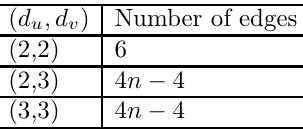
Figure 1. The molecular graph of a linear [n]-phenylenic.